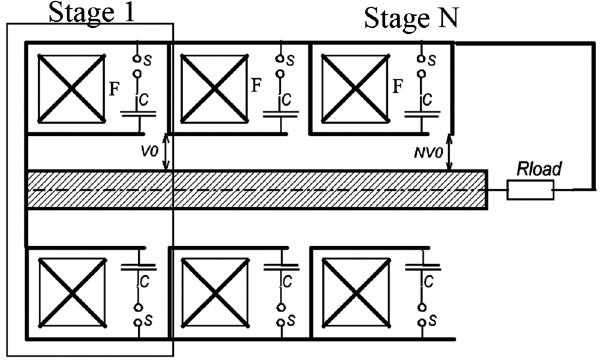
FIG. 1. Principal schematics of the LTD